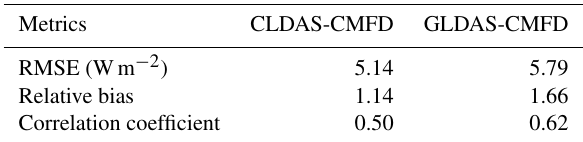
Table 6. Statistical metrics for monthly mean shortwave radiation anomalies among forcing data sets during